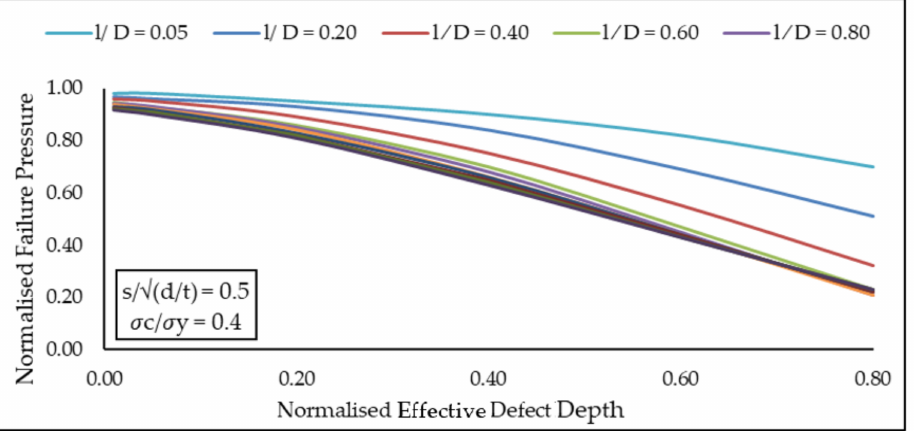
Figure 16. Normalized failure pressure predictions based on the empirical equation against various normalized defect depths for multiple normalized defect lengths at constant normalized defect spacing of 0.5 and normalized axial compressive stress of